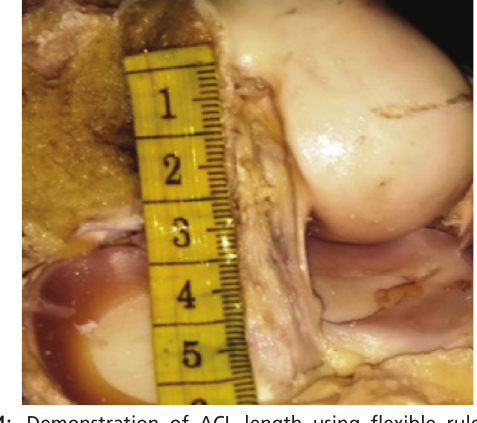
Demonstration of ACL length using flexible ruler (for Fig. 4: demonstration).